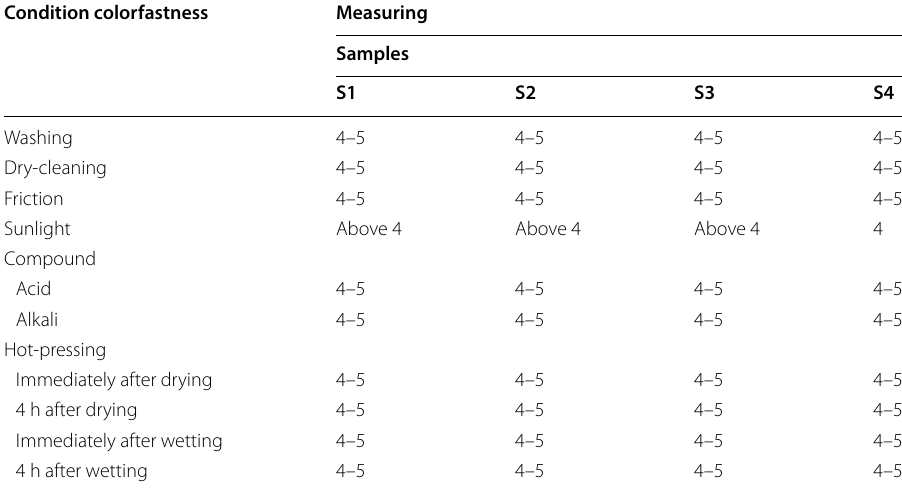
Table 3 Colorfastness of 4 sample fabrics on washing, dry-cleaning, friction, sunlight, compound (sweat sunlight), and +